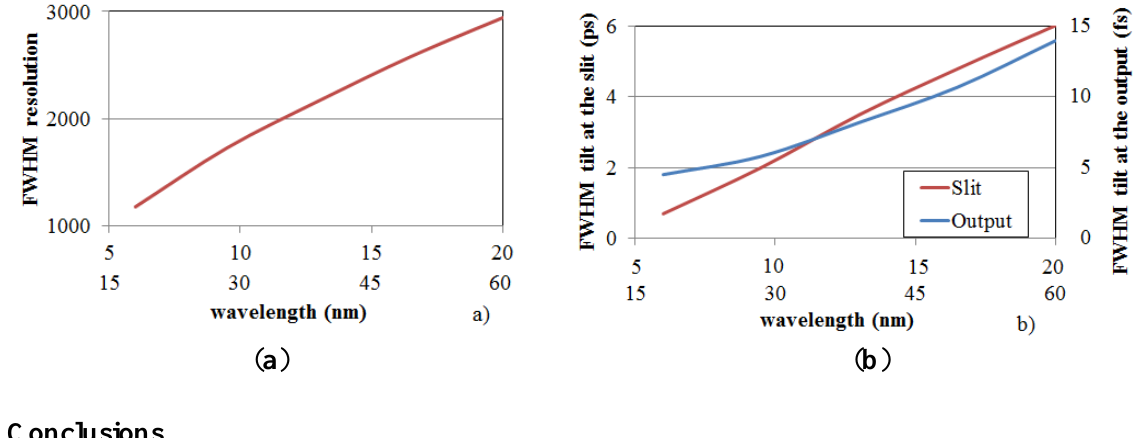
Figure 5. Resolution on a 50-  m slit ( a ) and pulse front-tilt ( b ) of the double-grating monochromator for FLASH II. The two scales on the x-axis refer to the two grating sets. The values in the y-axis are the same for both sets of